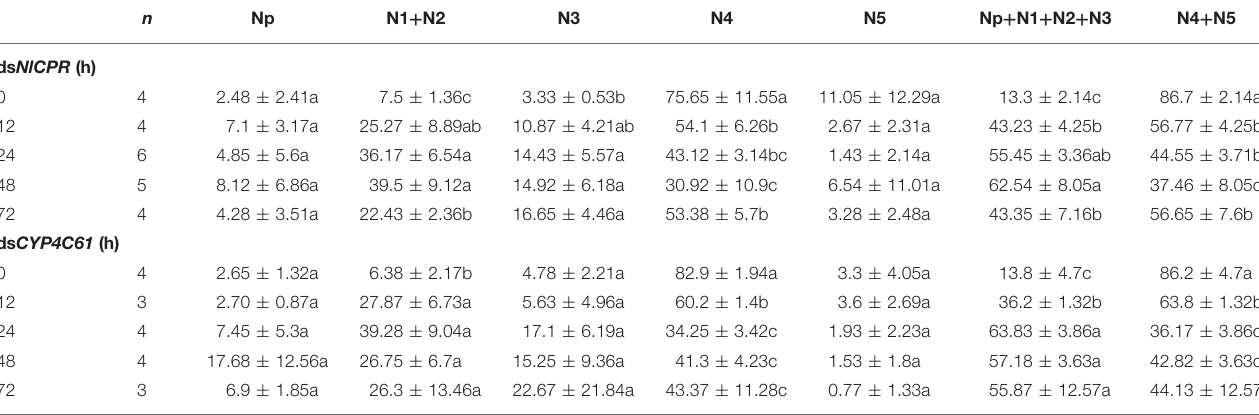
TABLE 1 | Comparison of different EPG waveform feeding patterns of NlCPR and CYP4C61 dsRNA-treated BPH at different time points while feeding on YHY15 plants for 3h (percentage duration and standard